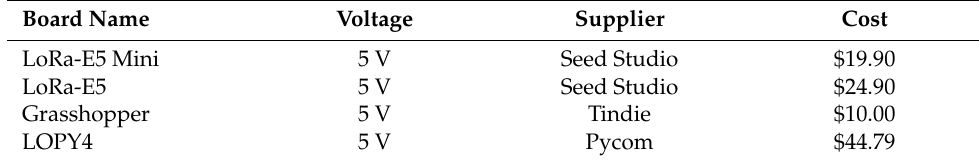
Table 2. Boards Chosen For Testing.